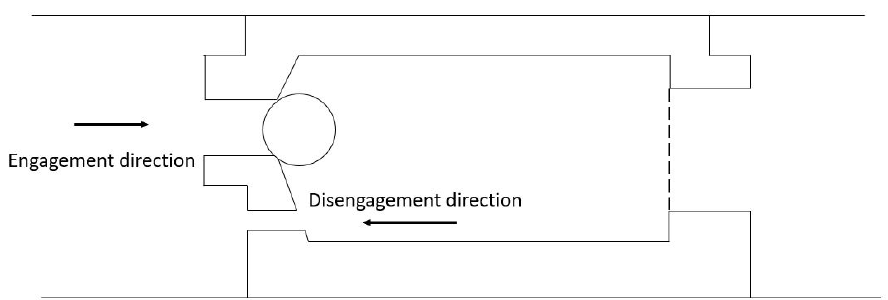
Figure 2: Possible one-way valve to be used inside the ARC system.